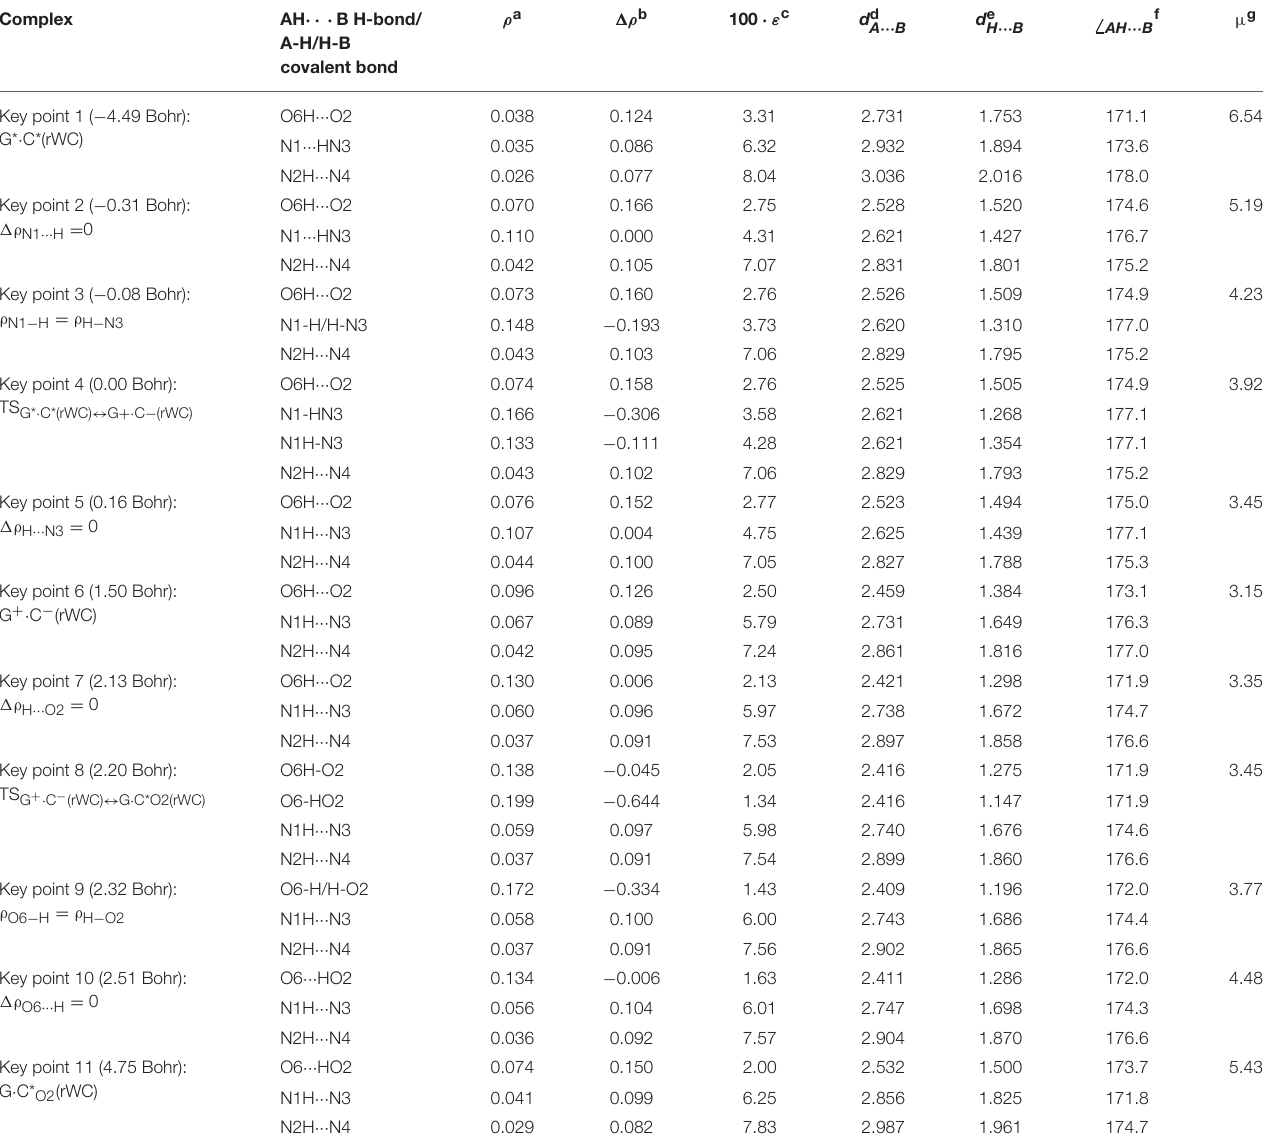
TABLE 3 | Electron-topological and structural characteristics of the specific intermolecular bonds revealed in the 11 key points and the polarity of the latters along the IRC of the I.